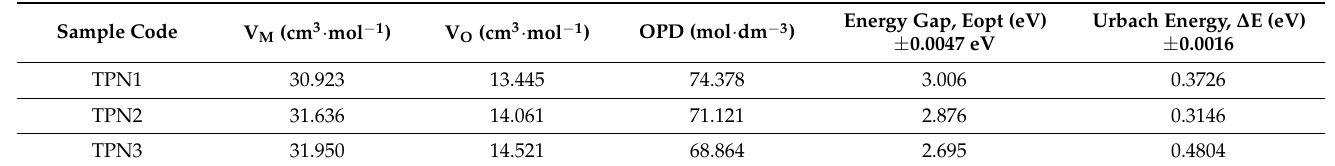
Table 2. The molar volume (V M ), oxygen molar volume (V O ), oxygen packing density (OPD), energy gap (E opt ), and Urbach energy ( ∆ E) of the fabricated